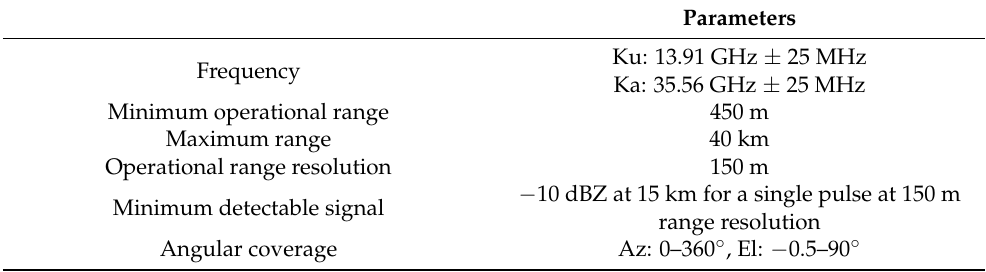
Table 2. Operating parameters of D3R